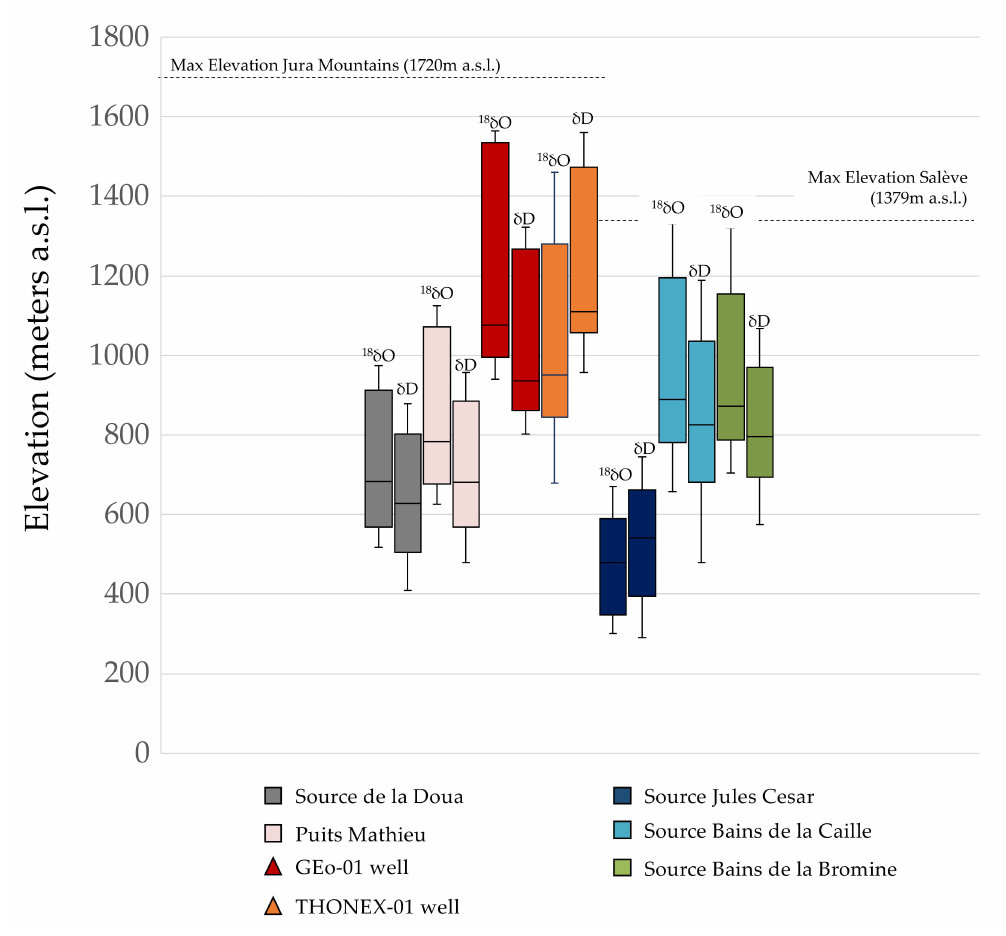
Figure 13. Elevation of the recharge zone constrained by isotopes relationships for Oxygen and Hydrogen (see full dataset in Supplementary